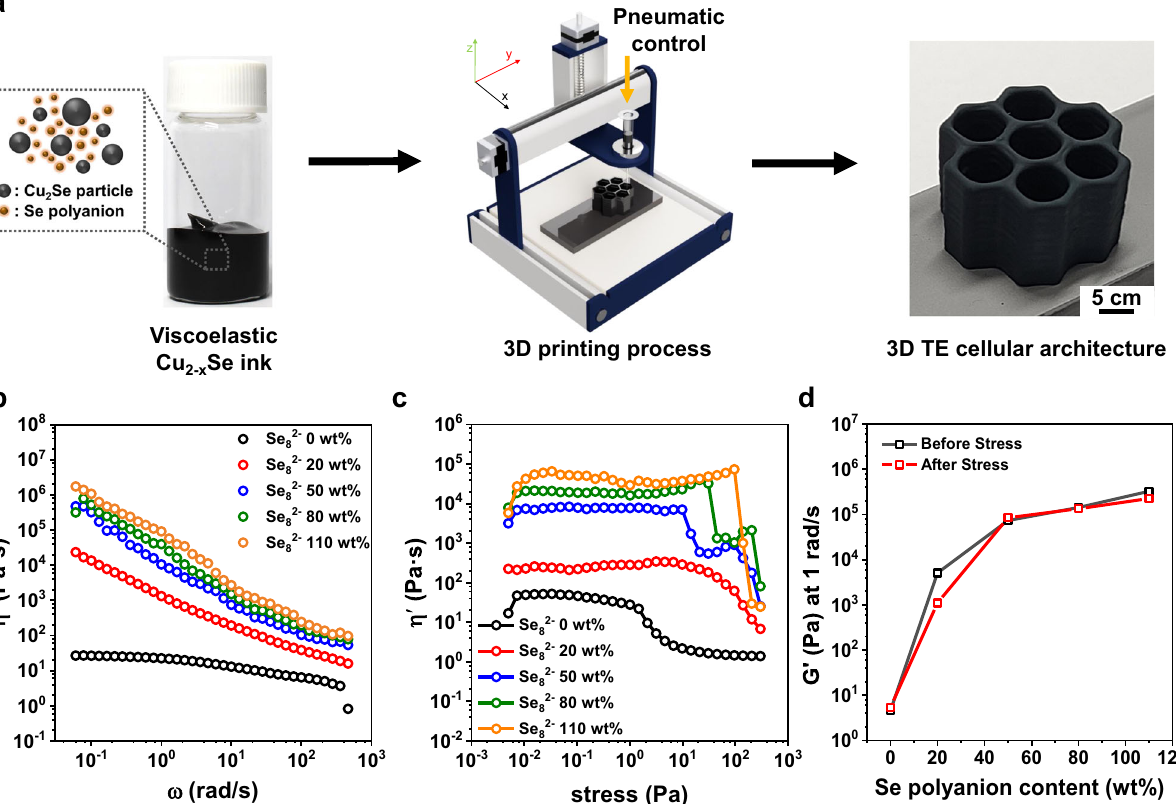
Fig. 2 Optimized viscoelasticity of Cu 2 Se-based ink. a Scheme for 3D printing process of the Cu 2 Se-based honeycomb cellular architecture by using all- inorganic Cu 2 − x Se ink. b The dynamic viscosity ( η ‘ ) curves of all-inorganic Cu 2 Se TE inks from the frequency sweep test. c Stress sweep results of the η ‘ over the shear stress range of 0.005 300 Pa. d The variation of storage modulus (G ’ ) and G ’ at 1 rad s − 1 as a function of the Se 8 2 − polyanion